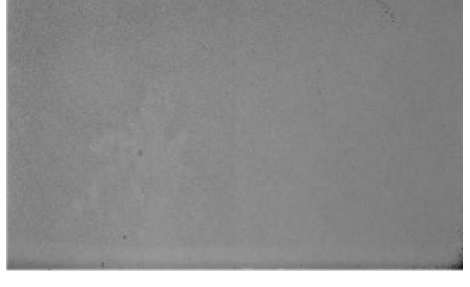
Figure 4. TIMS spectral image (spatial on vertical axis, spectral on horizontal axis) over no sun-glint.